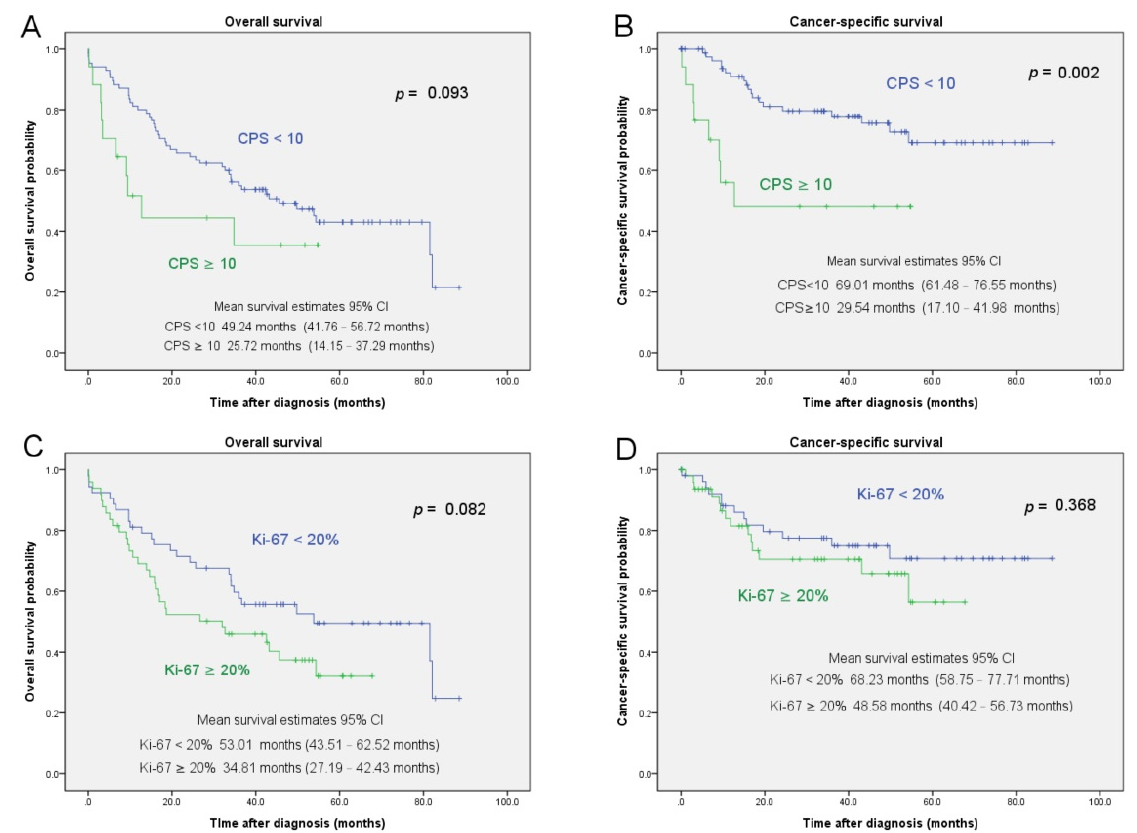
Figure 2. The OS and CSS estimates after RNU for patients with UTUC based on PD-L1 expression and Ki-67 overexpression. Subfigure A and B showed probability of OS and CSS after RNU stratified according to PD-L1 expression, respectively. Subfigure C and D showed probability of OS and CSS after RNU stratified according to Ki-67 expression, respectively.